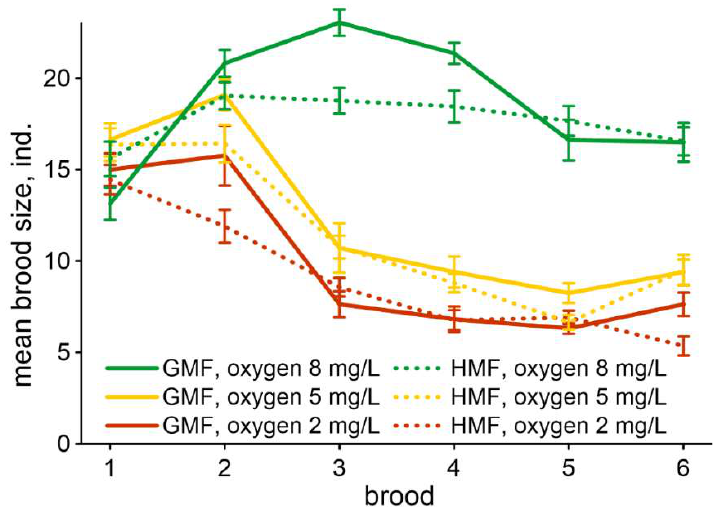
Figure 2. Dynamics of changing mean brood size in studied groups of daphnids. Bars denote standard error.